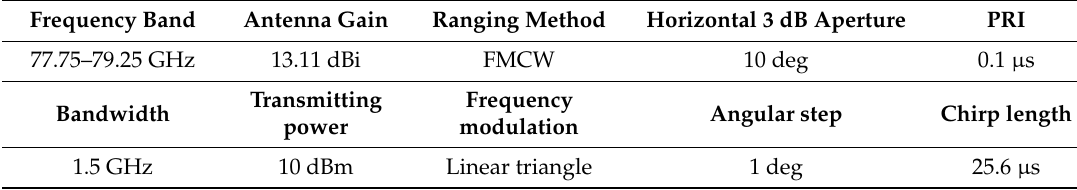
Table 2. Specifications of the 78.5 GHz radar.